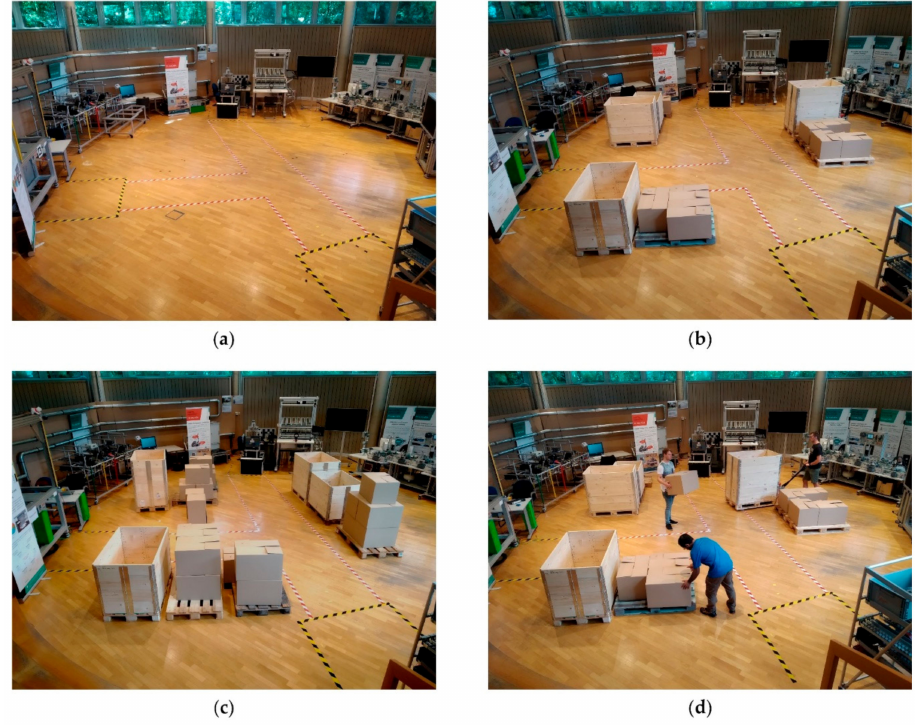
Figure 16. Localization test scenarios. ( a ) S static ; ( b ) S crowded ; ( c ) S crowded ∗ ; ( d ) S dynamic